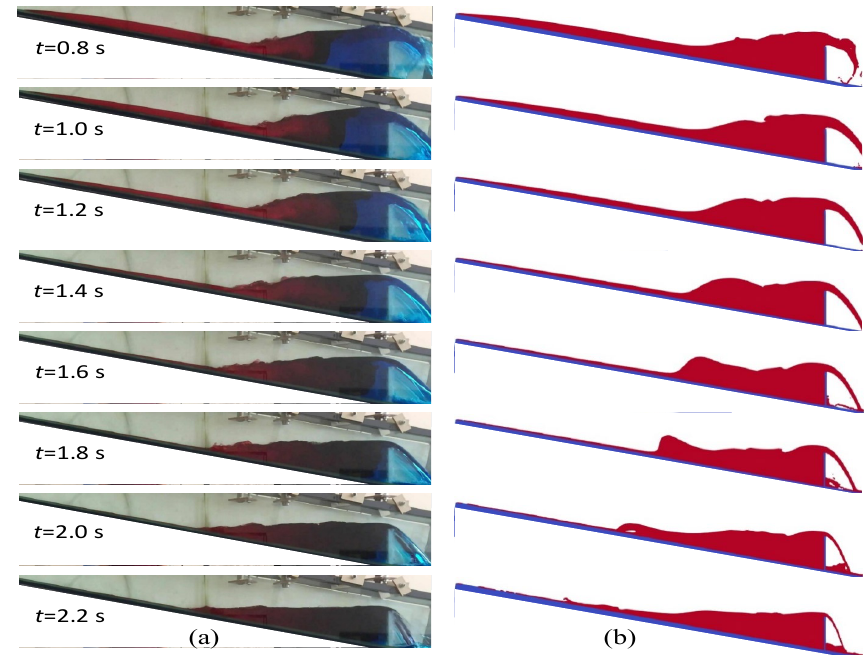
Figure 12. Visual comparison of the overtopping and the reflected wave due to the downstream dam ( a ) experiment ( b ) SPH.